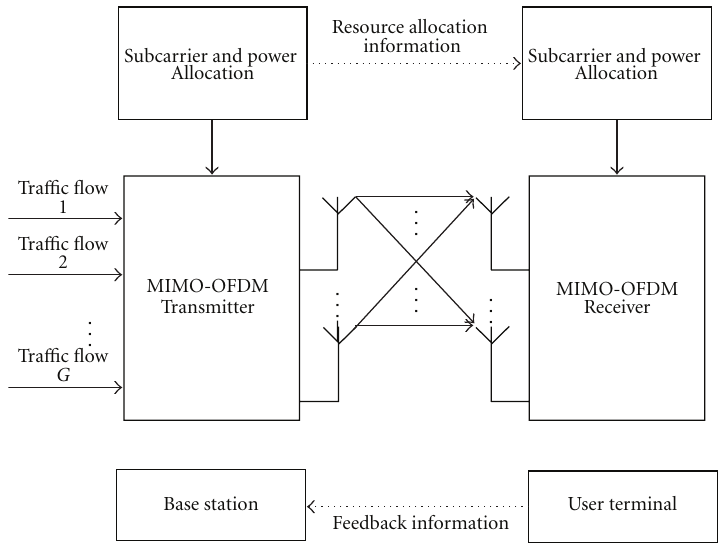
Figure 2: Block diagram of MIMO-OFDM multicast